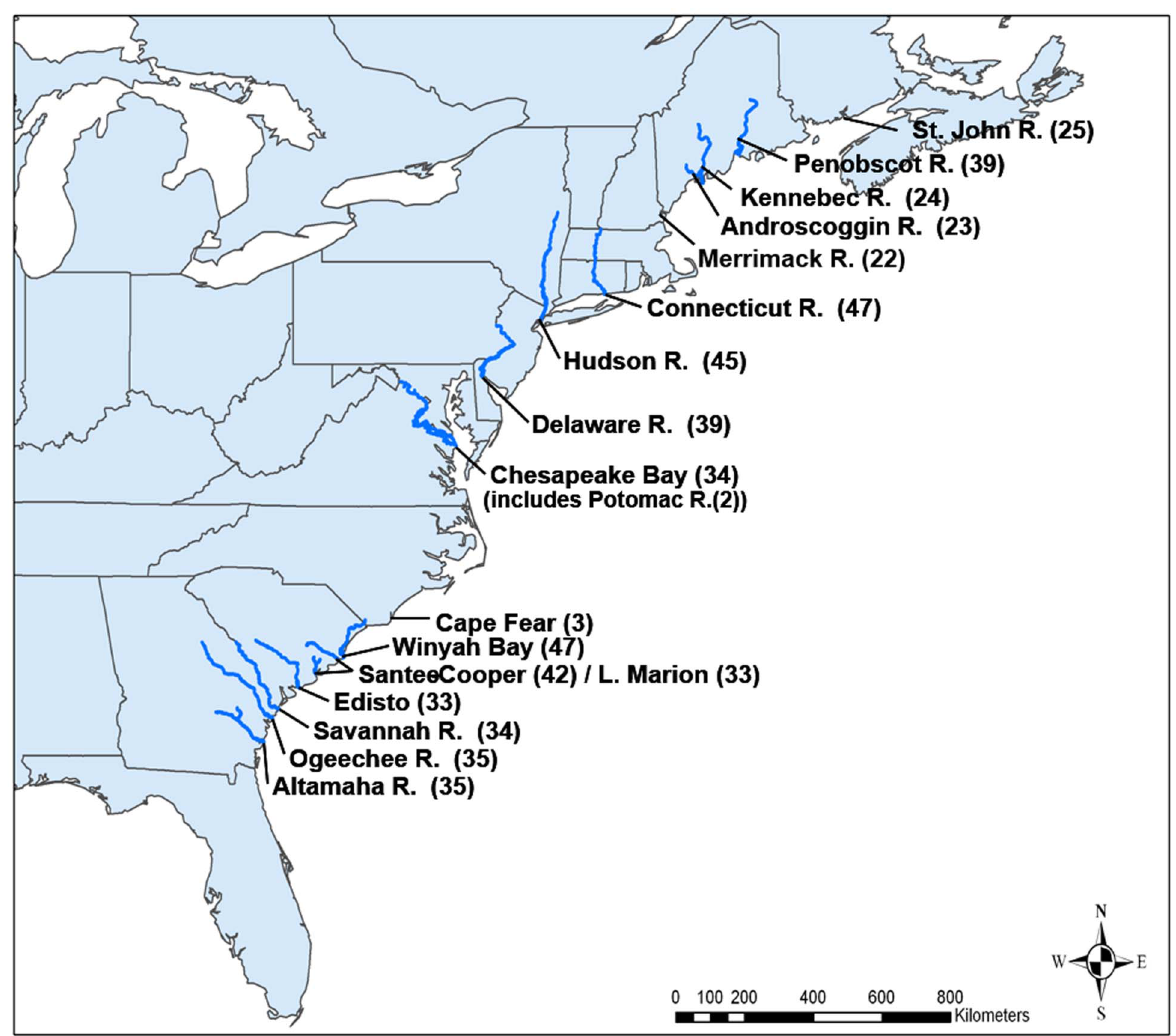
Figure 1. Map of a portion of the North American Atlantic Coast depicting the general location and sample size of 17 river and estuary collections of shortnose sturgeon ( Acipenserbrevirostrum ) surveyed at 11 polysomic microsatellite DNA loci. Sample sizes are in parentheses.